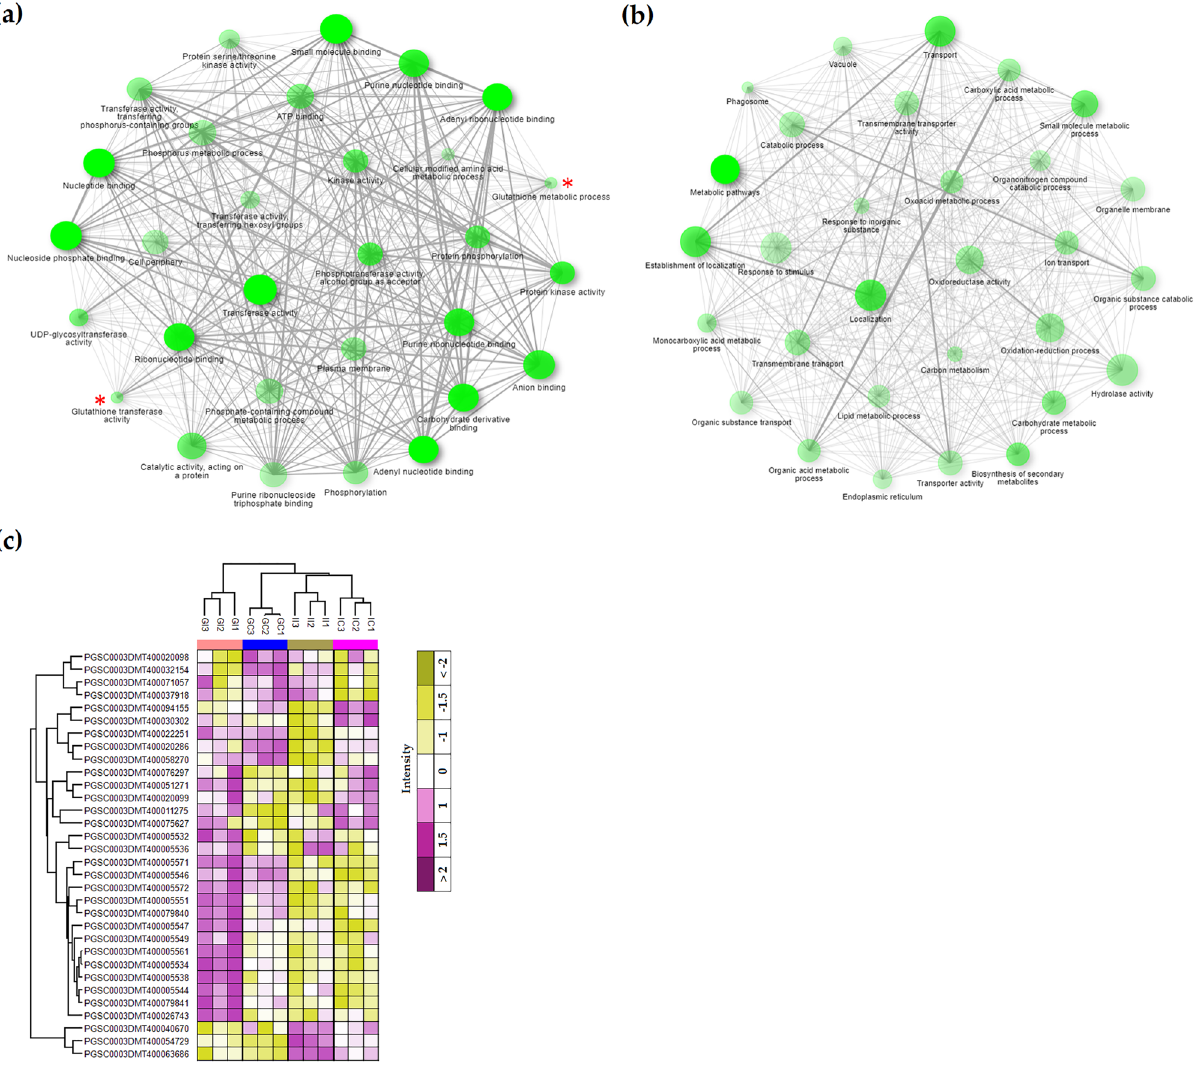
Figure 2. Association networks analysis of the enriched pathway of upregulated DEGs in ( a ) Gladiator and ( b ) Iwa. Darker nodes (more intense in colour) are more significantly enriched gene sets and bigger nodes represent larger gene sets. Thicker edges represent more overlapped genes. The pathways related to “glutathione metabolism” are marked with the red asterisk. ( c ) The Z-scored (normalized) expression of GST genes in the infected and control potato plants. GI, Gladiator infected; GC, Gladiator control; II, Iwa infected; IC, Iwa